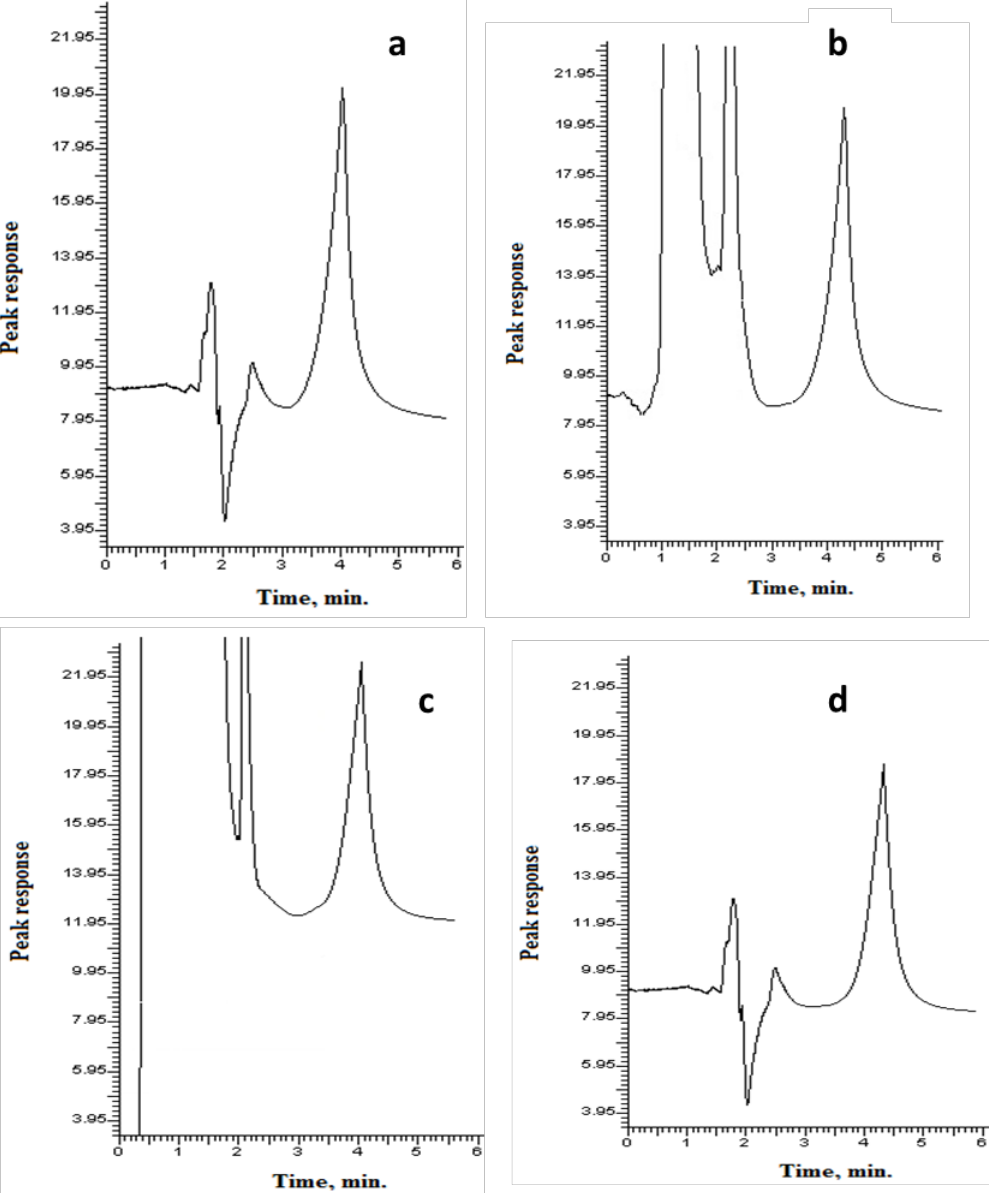
Figure 2. A typical chromatogram for 500 ng/mL of VNB under described chromatographic condi- tions: 0.3% triethylamine and 5% n -butanol in a solution of 0.05 M SDS was adjusted to pH 3 utilizing 0.02 M orthophosphoric acid and pumped at a flow rate of 0.7 mL min −1 : ( a ) pure, ( b ) human urine, ( c ) human plasma and ( d ) HLMs.